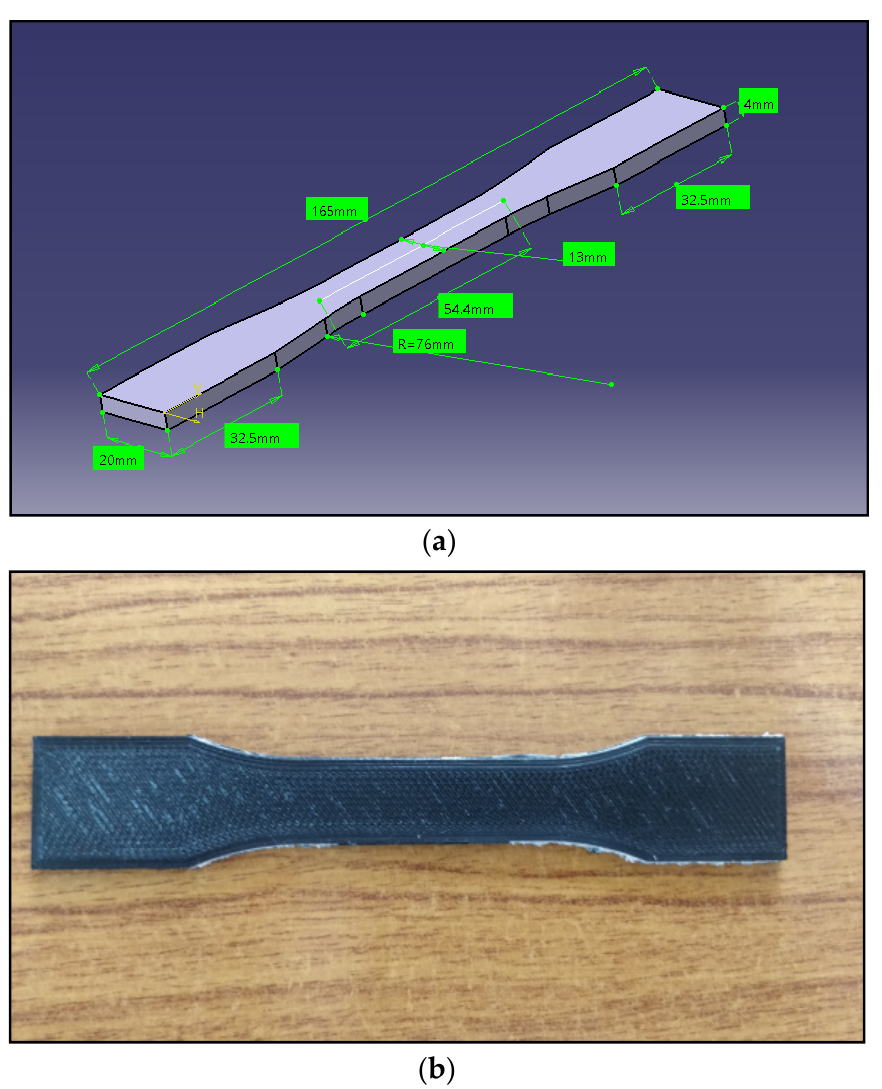
Figure 6. ( a ) Tensile specimen dimensions. ( b ) Photograph of tensile specimen.